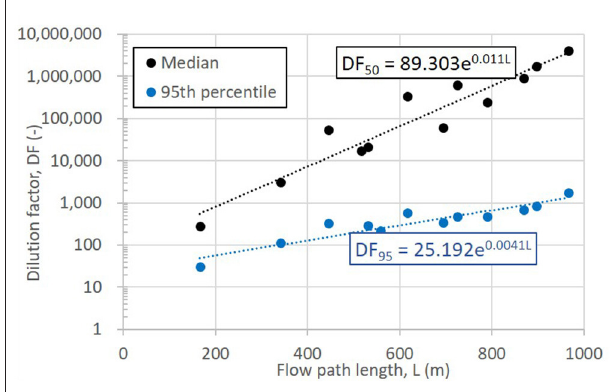
FIGURE 11 | Median (DF 50 ) and 95th percentile dilution factors (DF 95 ) vs. flow path